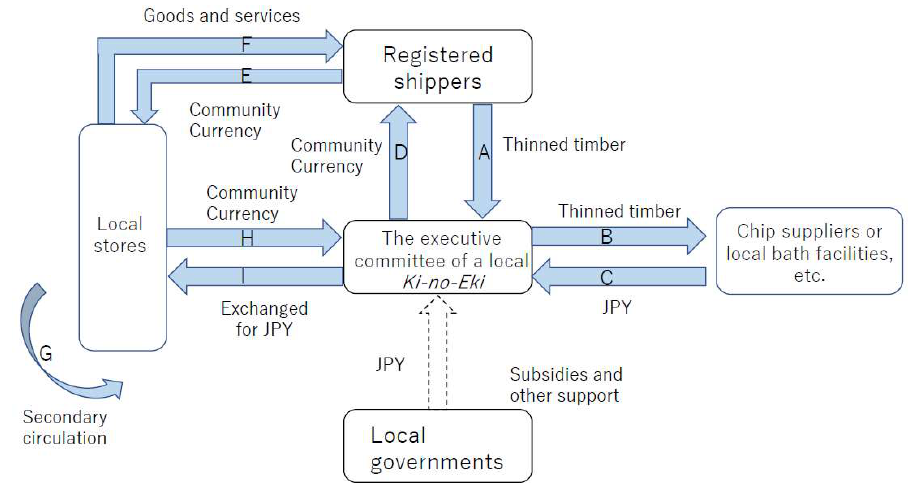
Figure 1. The structure of a Ki-no-Eki ( Source : Izumi and Nakazato [1] (p. 44)).